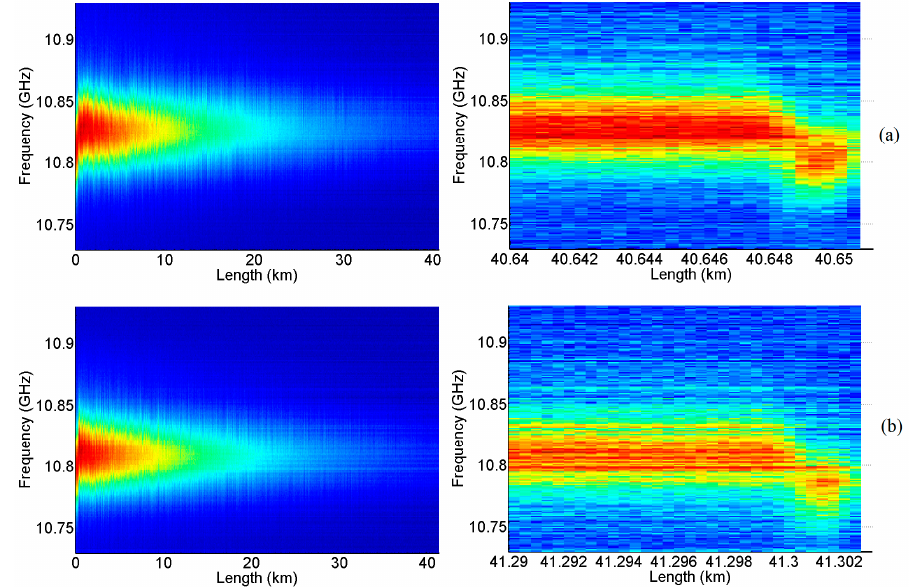
Figure 4. BGS as a function of distance measured at ( a ) the λ 1 channel along FUT I (left) and the corresponding zoom-in view of the last 10 m of the fiber (right), and ( b ) the λ 2 channel along FUT III (left) and the corresponding zoom-in view of the last 12 m of the fiber (right).